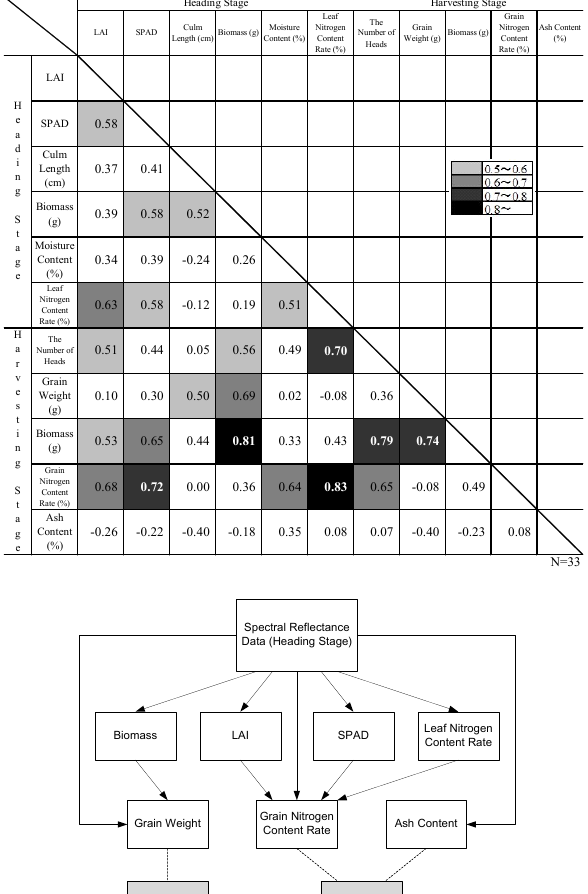
Table 3: Correlations between Estimation Items